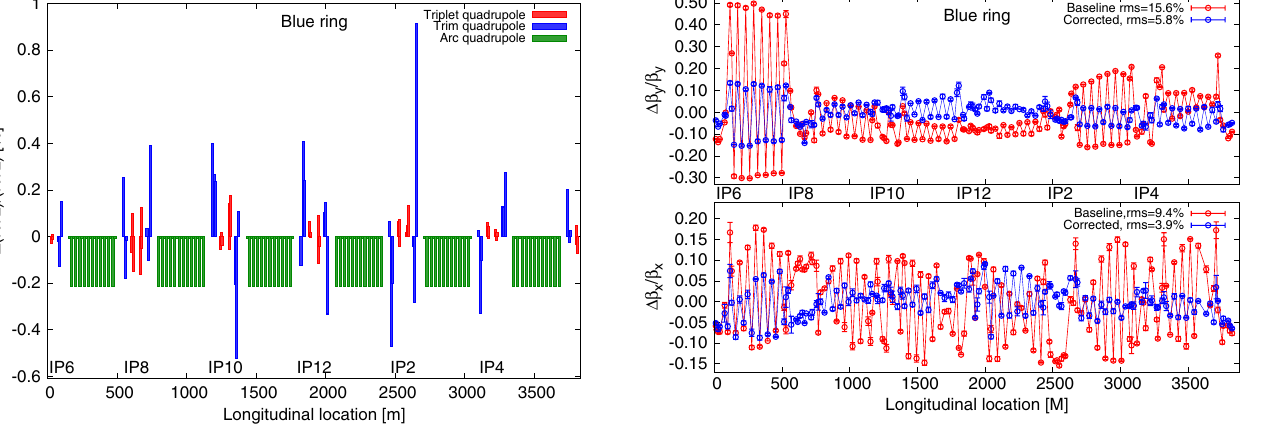
FIG. 2. Relative changes of quadrupole integrated strength as a function of quadrupole locations in the Blue